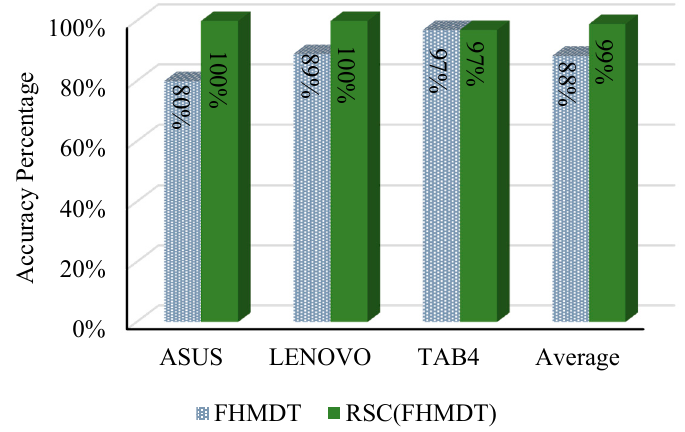
Figure 17. Floor positioning accuracy percentage before and after applying RSC, FHMDT and RSC (FHMDT).